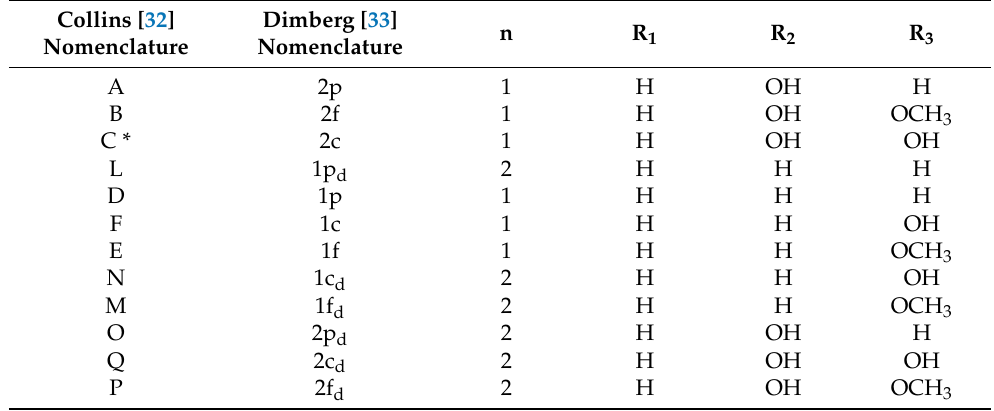
Table 1. The nomenclature of oat avenanthramides, with n and R groups corresponding to the respective avenanthramide structures, as indicated in Figure 2.